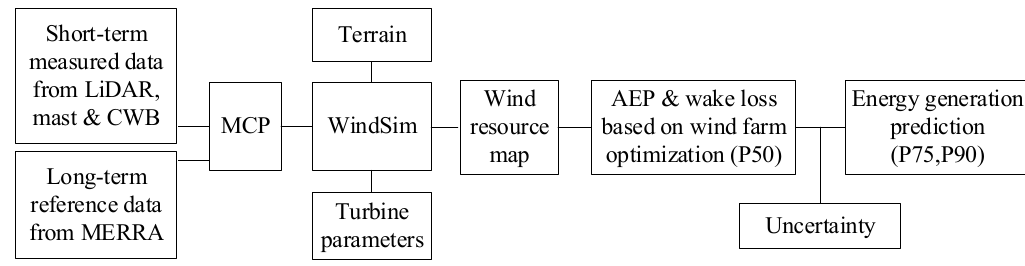
Figure 1. Flowchart of the present study.